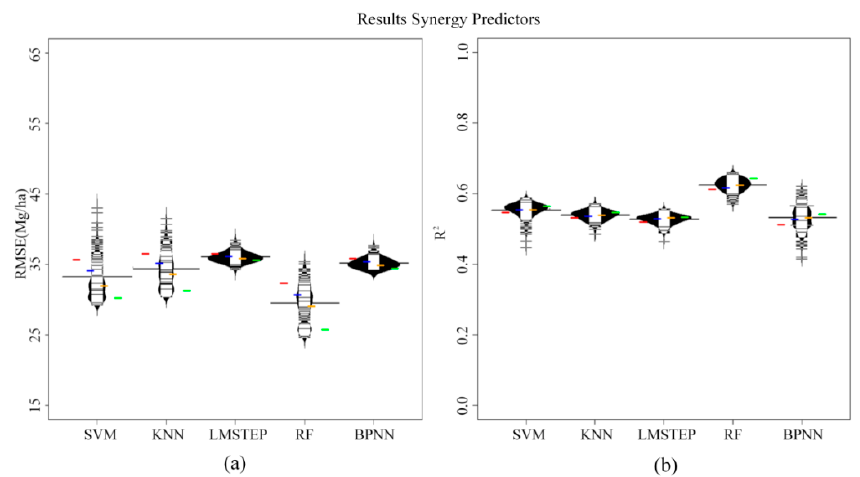
Figure 3. The beanplots illustrate the distribution of the mean RMSE ( a ); and R 2 ( b ) values from the 100 bootstrapped models obtained by the 5-fold-cross validation for each prediction method and sample size with optical and microwave integrated dataset in Experiment 1 (iii). Furthermore, the median values of the corresponding accuracy measures for each of the four sample size classes are given with the colored horizontal stripes (Class 1 to Class 4 from left to right in colors red, blue, yellow and green).